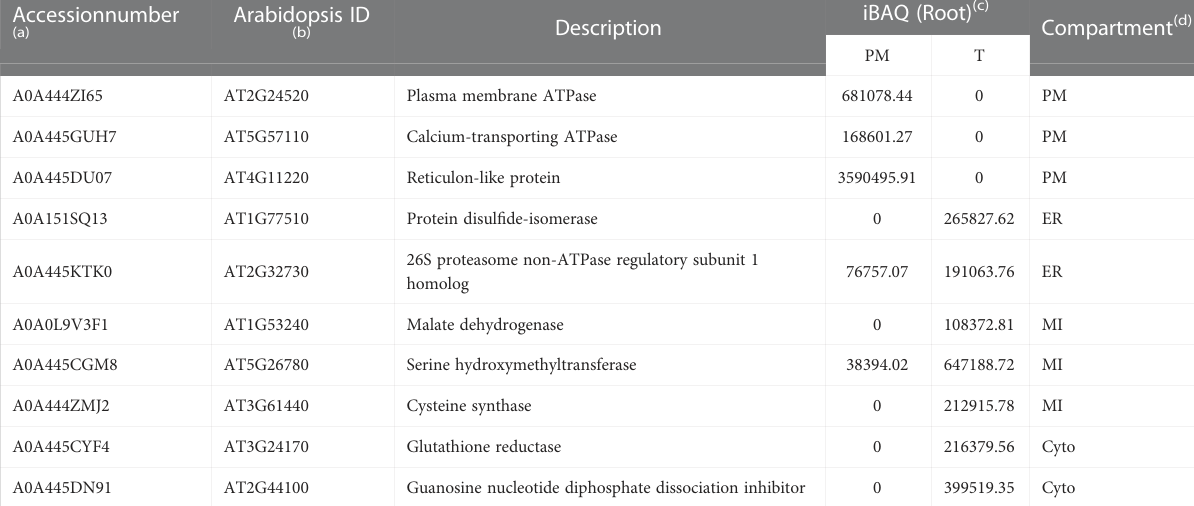
TABLE 2 Representative list of PM, ER, MI and Cyto proteins in PM and T fractions of roots measured by mass spectrometry. Accessionnumber